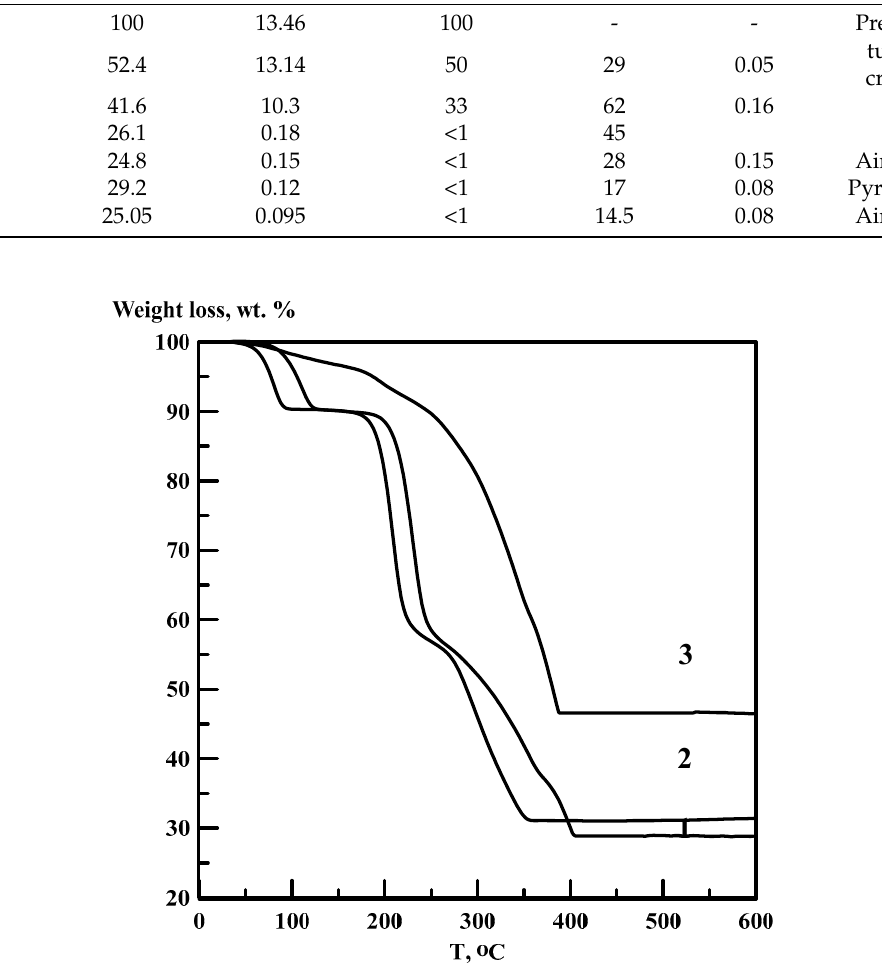
Figure 2. Thermal gravimetric (TG) curves for [Co(NH 3 ) 6 ][Fe(C 2 O 4 ) 3 ] ∙ 3H 2 O with heating rate 10°/min (1) 3°/min (2) and TG curve of the intermediate product I-1 (3) (heating rate 3°/min).